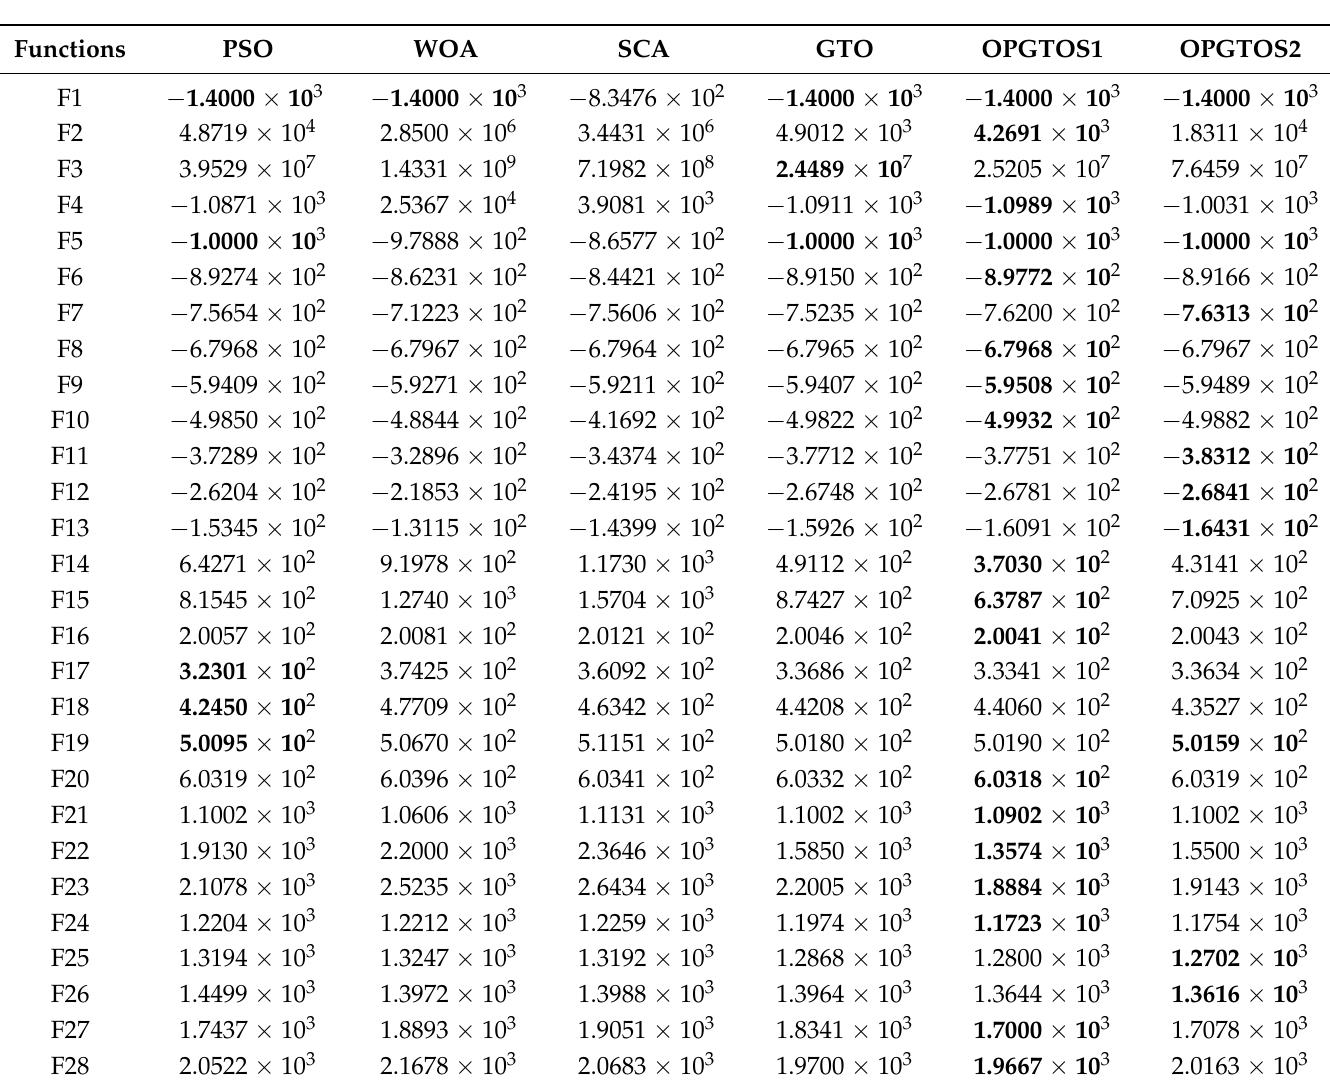
Table 2. Simulation results of CEC2013 functions in 10